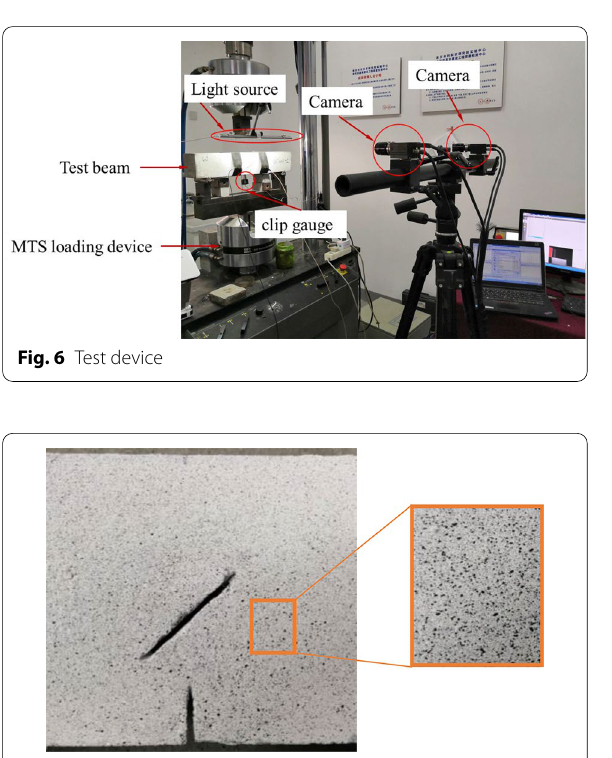
Fig. 7 Speckle pattern on the specimen